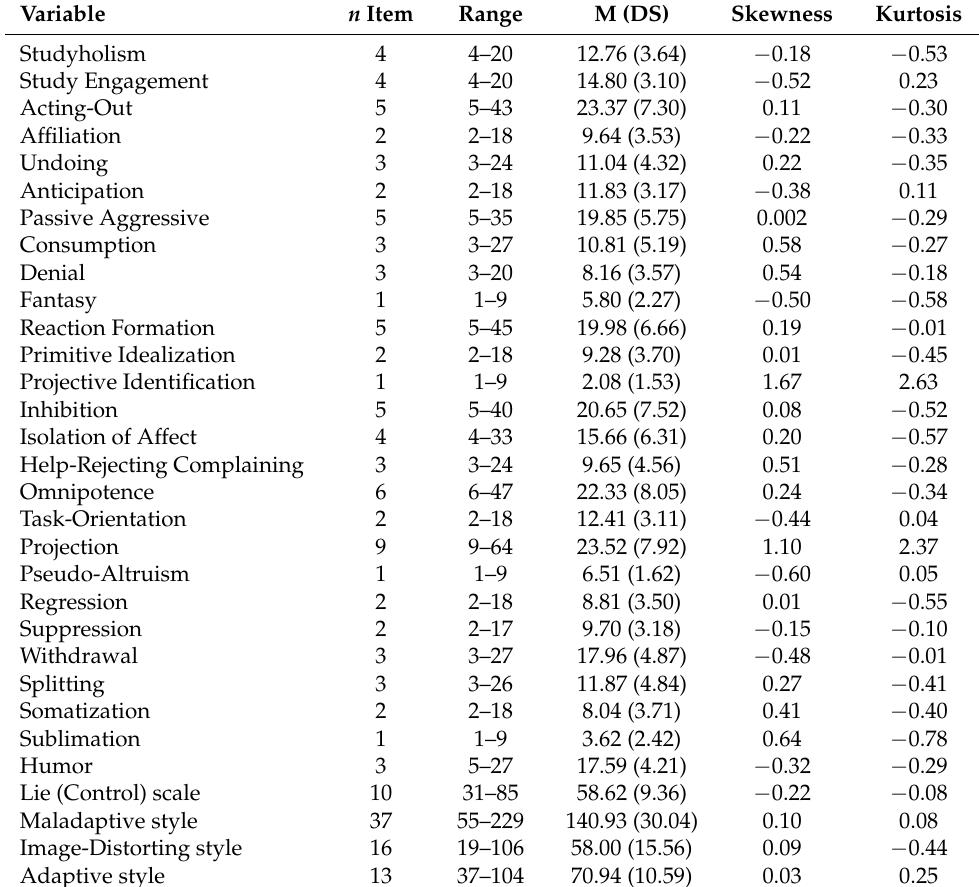
Table 1. Descriptive statistics of the variables ( n = 422).